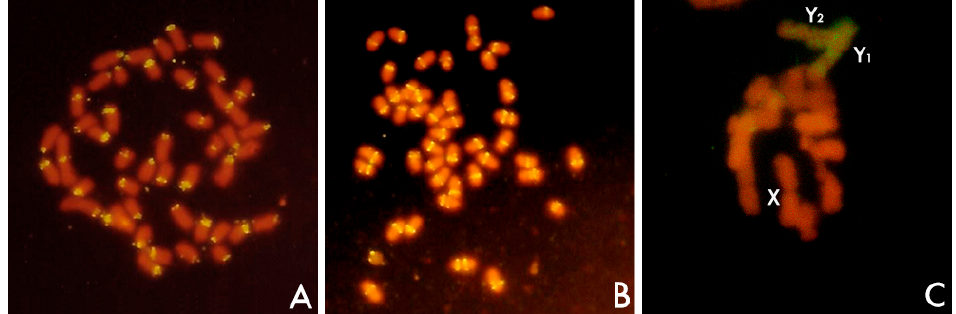
Figure 2. Fluorescent in situ hybridization (FISH) using satDNA probes. Probes were labeled with digoxigenin-dUTP and detected with antidigoxigenin FITC-conjugate. FITC (Fluorescein IsoTioCyanate) is a fluorochrome derivative of fluorescein which fluoresces yellowish-green. In these pictures, yellowish-green signals correspond to detected probes while chromosomes are counterstained with ethidium propide (red). ( A ) EcoRI satDNA is the main component of the centromeres of the chromosomes of the fish species of the Sparidae family. This picture shows the detection of the hybridization signals of EcoRI repeats on the centromeres of all the chromosomes of Diplodus bellotti [30]. ( B ) DraI satDNA is located in the subtelomeric region of the chromosomes of some sparid species [29]. This picture shows the detection of the hybridization signals of DraI repeats at the subtelomeric region of many of the chromosomes of Pagrus auriga . The chromosomes of this species are all acrocentric. Also look for the presence of some interstitial loci in some of its chromosomes. ( C ) RAE180 satDNA is highly amplified in the Y chromosomes of males (XY 1 Y 2 ) of the dioecius plant species Rumex acetosa [25,26,28]. This picture shows the detection of the hybridization signals of RAE180 repeats which are widespread in the major part of the two Y chromosomes. Sex chromosomes are indicated